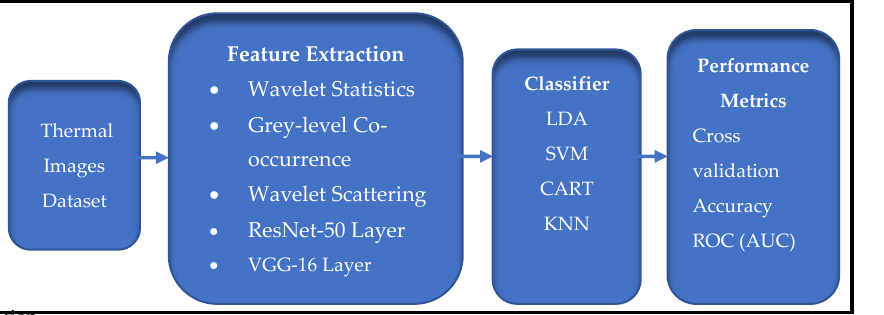
Figure 2. High level block diagram of the comparison study of various ML and DL methods validated for better performance in occupancy